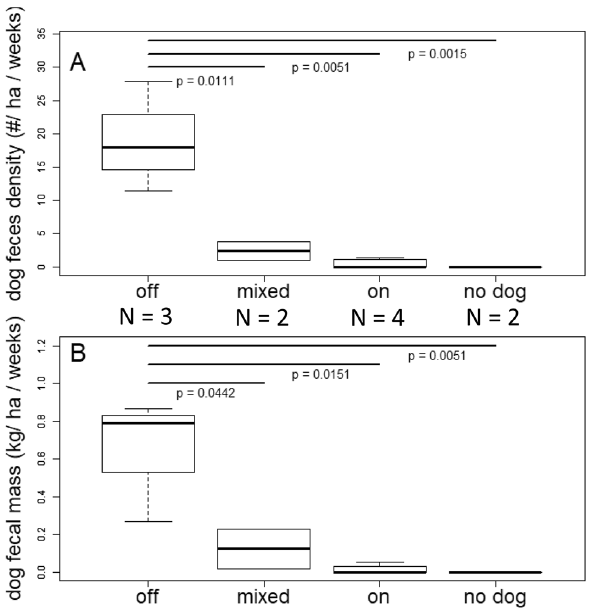
Figure 2. Dog fecal contamination expressed as the number ( A ) and mass in kg ( B ) in per hectare per week in the parks and natural areas in the City of Calgary (AB, Canada) surveyed in summer 2011 in relation to their dog leash policy: “off” for parks where dogs are allowed off-leash, “on” for parks where dogs are allowed on-leash, “mixed” for parks containing both off-leash and on-leash areas, and “no dog” for parks where dogs are not allowed. Both the numbers of feces and fecal masses show significant difference between off-leash parks and every other leash policy based on Tukey tests. The pairs that are significantly different are highlighted with horizontal lines and p-values.